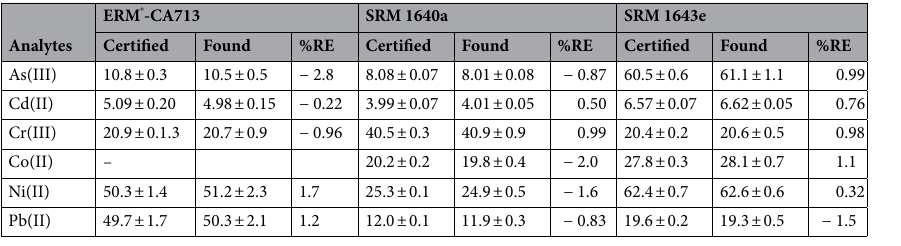
Table 4. Determination of As(III), Cd(II), Cr(III), Co(II), Ni(II) and Pb(II) ions (concentration, μg L −1 ) in certified and standard reference materials.